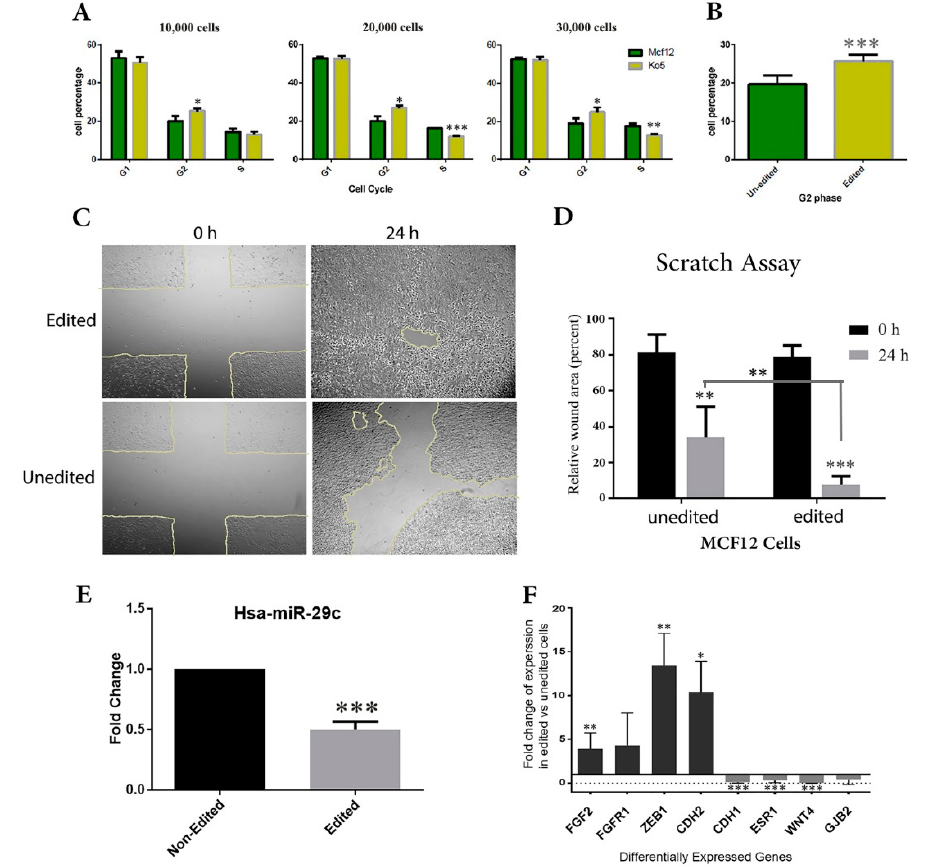
Figure 6. Functional analysis of C1orf132 . ( A ) Flow cytometry was used to explore cell cycle distribution for edited ( C1orf132 -promoter eliminated) vs. unedited MCF12A cells. ( B ) Data obtained from three different biological repeats demonstrated a G2/M arrest in edited cells ( p < 0.001). ( C , D ) Scratch (wound healing) assay was employed as a tool to monitor cell migration in edited ( C1orf132 -promoter eliminated) vs. unedited MCF12A cells. As it is clearly demonstrated in microscopic pictures, after 24 h the uncovered areas of the plates were significantly decreased ( p < 0.05) in cells edited for C1orf132 expression. ( E ) The expression level of miR-29c-3p in C1orf132 -promoter eliminated cells was significantly reduced by half compared to wild-type MCF12A cells. ( F ) Several genes were differentially expressed in edited vs. unedited MCF12A cells; FGF2 and its receptor FGFR1 , ZEB1 and CDH2 were overexpressed almost 4 to 15 times in edited cells. Moreover, the expression level of some genes which were mostly epithelial makers, CDH1 , ESR1 , WNT4 and GJB2 were reduced in edited cells. As expected, the expression level of C1orf132 decreased as well. Asterisks indicate a significant difference (* p < 0.05, ** p < 0.01, *** p < 0.001).